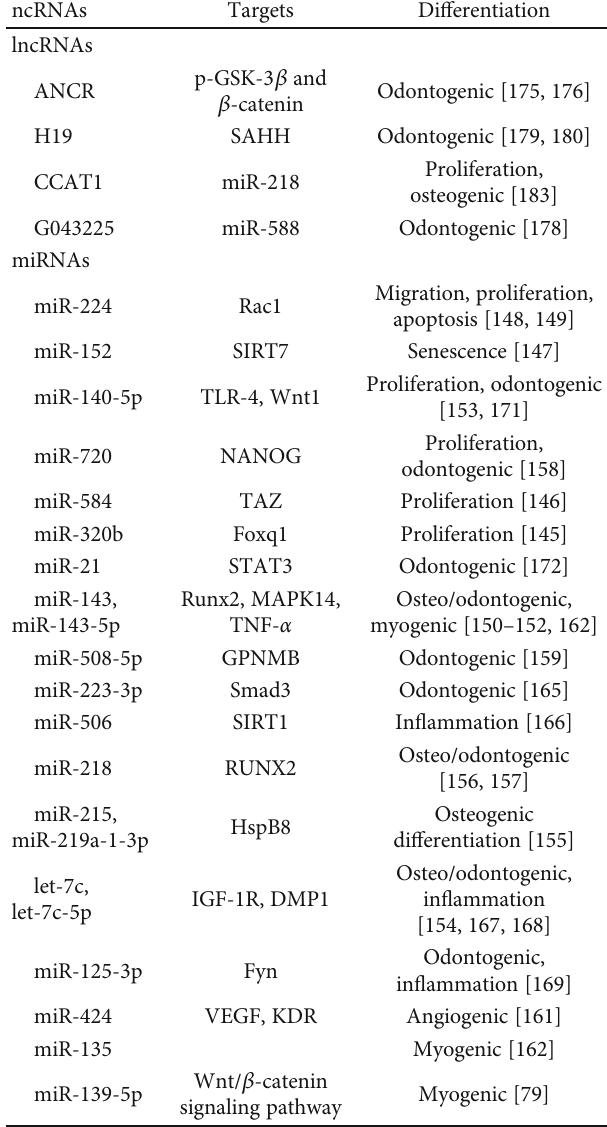
Table 3: ncRNAs in